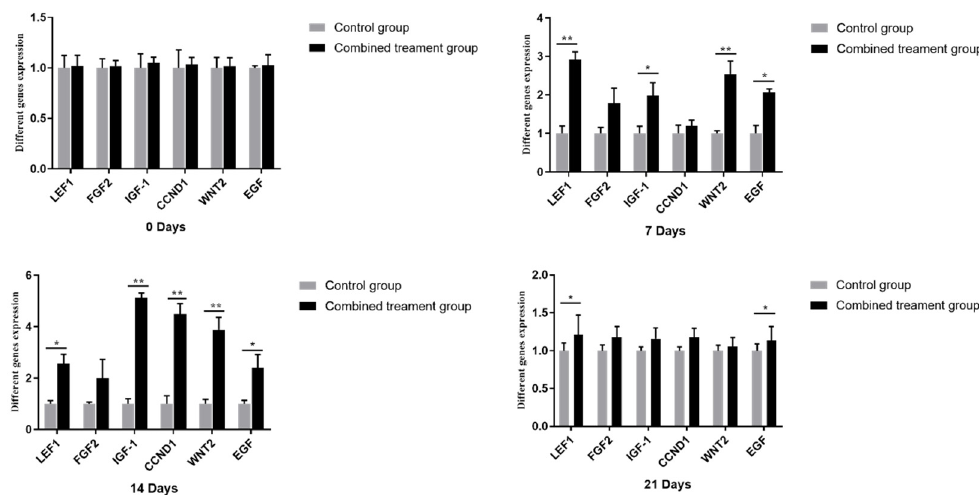
Figure 7. Examination of the influence of IGF-1 and EGF on HF development related genes at 0, 7, 14 and 21 days post-subcutaneous treatment. Histograms represent means ± SD of triplicate experiments. For significance, * p < 0.05, ** p < 0.01.